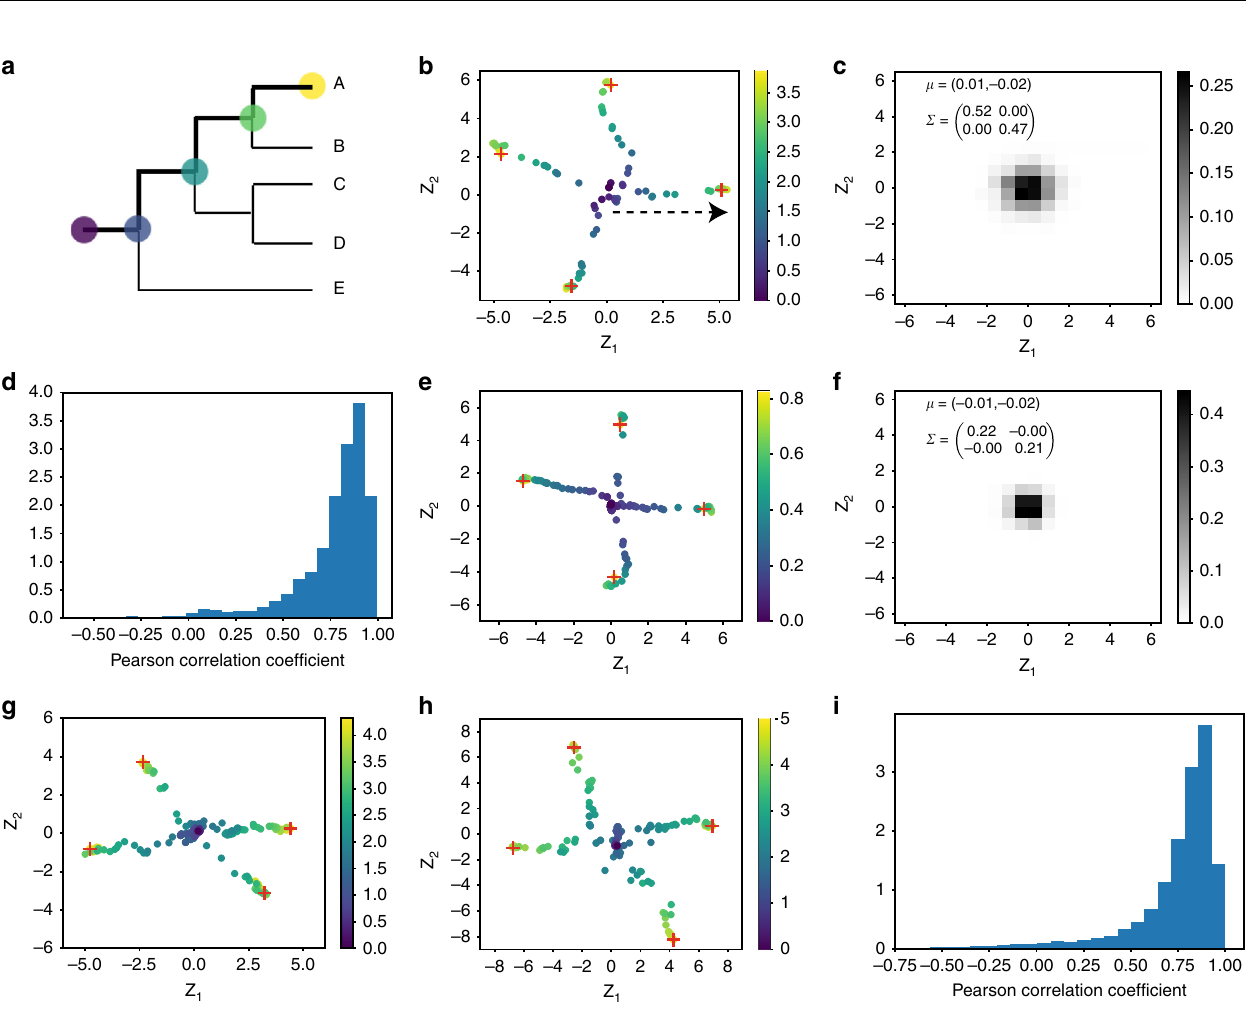
Fig. 3 Latent space representation of sequences captures ancestral relationship between sequences. a – d Results for simulated MSAs based on random phylogenetic trees: a A schematic representation of the phylogenetic tree used to simulate the evolution of a random protein sequence with 100 amino acids. It is the same tree as in Fig. 2d. Here the evolutionary trace from the root node to the leaf node A is highlighted as bold lines. Nodes along the highlighted evolutionary trace are colored based on the evolutionary distance from the root node using the color bar shown in b . b Latent space representation of four representative leaf node sequences, labeled as plus signs, and their ancestral sequences, labeled as dots. Sequences are colored based on their evolutionary distances from the root node. The sequence of the root node sits around the origin in the latent space. As the sequence evolves from the root node to a leaf node, its latent space representation moves from the origin toward the surroundings along a direction. The moving direction, labeled as a dashed arrow line for the right most leaf node, is calculated as the fi rst component direction using principal component analysis. c The distribution of the root node sequence position in the latent space estimated using 2000 repeats. d As shown in b , evolutionary distances of sequences are correlated with their positions along the fi rst component direction in the latent space. The corresponding Pearson correlation coef fi cient can be calculated for each leaf node (see Supplementary Fig. 6A for the right most leaf node in b ). Here we show the distribution of Pearson correlation coef fi cients of all leaf node sequences. e , f Results on simulated MSAs based on the realistic phylogenetic tree of COG642: e A similar plot as b for the COG642 family. f A similar plot as c for the COG642 family. g , h Similar plots as b for the fi bronectin type III domain ( g ) and the cytochrome P450 family ( h ), respectively. i A similar plot as d for the fi bronectin type III domain